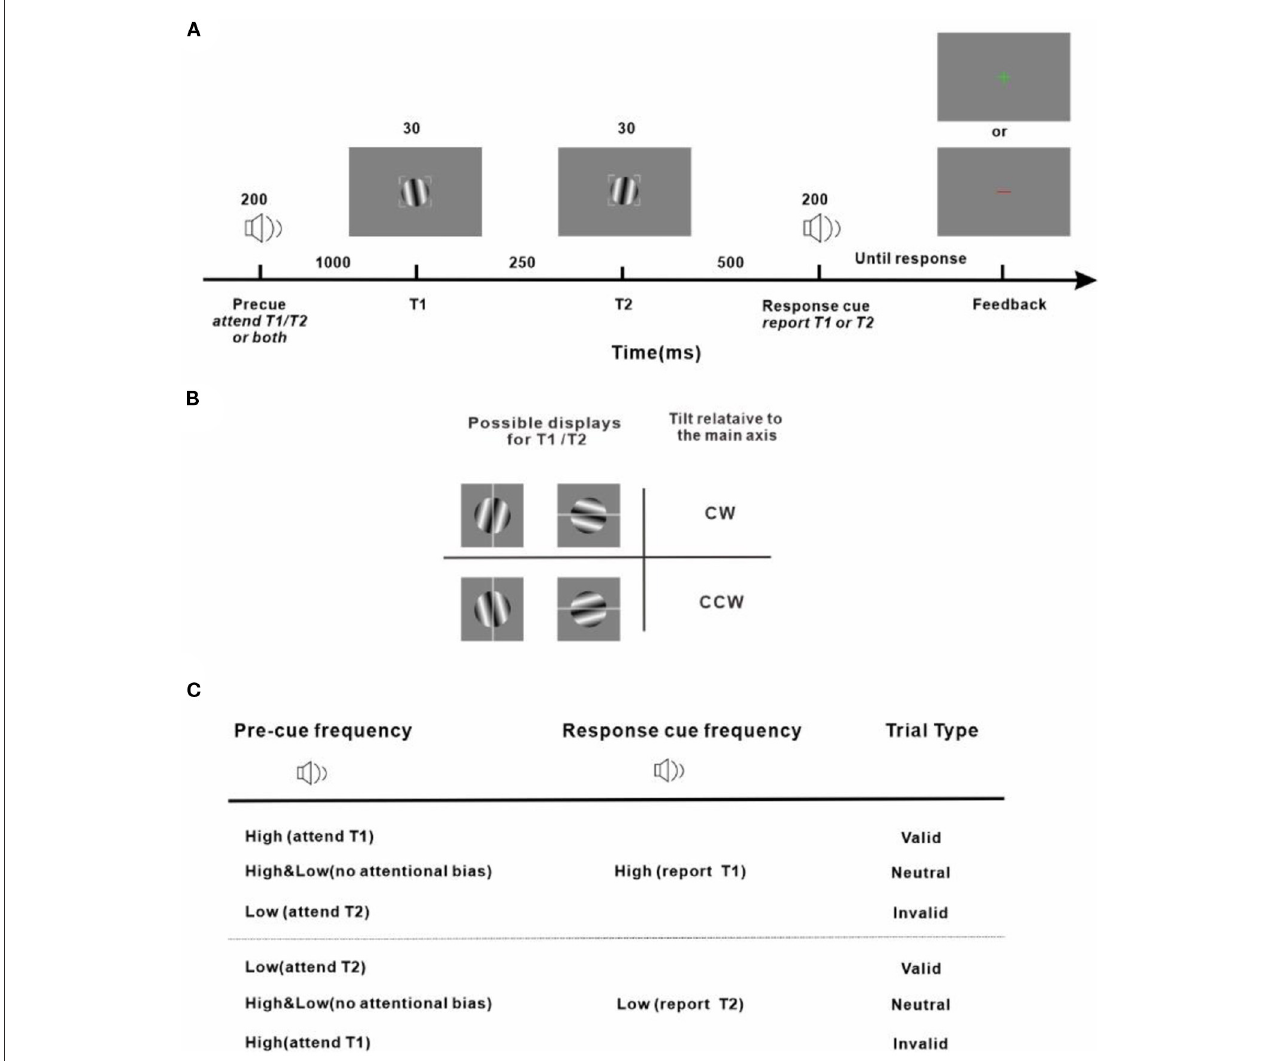
FIGURE2 Experiment protocol and response strategy (A) Trial sequence. Observers were asked to judge the tilt (clockwise or counter-clockwise) of a sinusoidal grating patch (T1 or T2, indicated by the response cue) from its main axis. (B) Stimulus display and response scheme. Observers reported clockwise vs. counter-clockwise tilts relative to either the vertical or horizontal axis depending on which was the closest cardinal axis of the target to be reported (indicated by the gray line for demonstration purposes and not shown during the experiment) by pressing one of two keys on the keyboard. All stimuli, pre-cues, and response cues were presented in randomly interleaved trials. Tilt magnitudes were determined for each observer using a staircase procedure. (C) Attention manipulation strategy with different pre-cue and response-cue correspondence. In valid trials, attention was correctly cued to the target to be reported. In invalid trials, attention was misdirected by the pre-cue to the stimulus that was not the reported one at the end of the trial. In neutral trials, there was no attentional preference for the two stimuli in the stream. The protocol is an adapted version of the well-established experimental design to investigate the effect of temporal attention on perception (Denison et al., 2017; Denison and Yuval-Greenberg, 2019; Fernández et al., 2019; Denison and Carrasco,